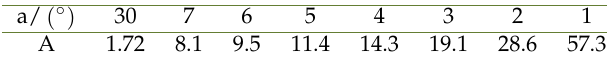
Table 2. Relation between A and α .